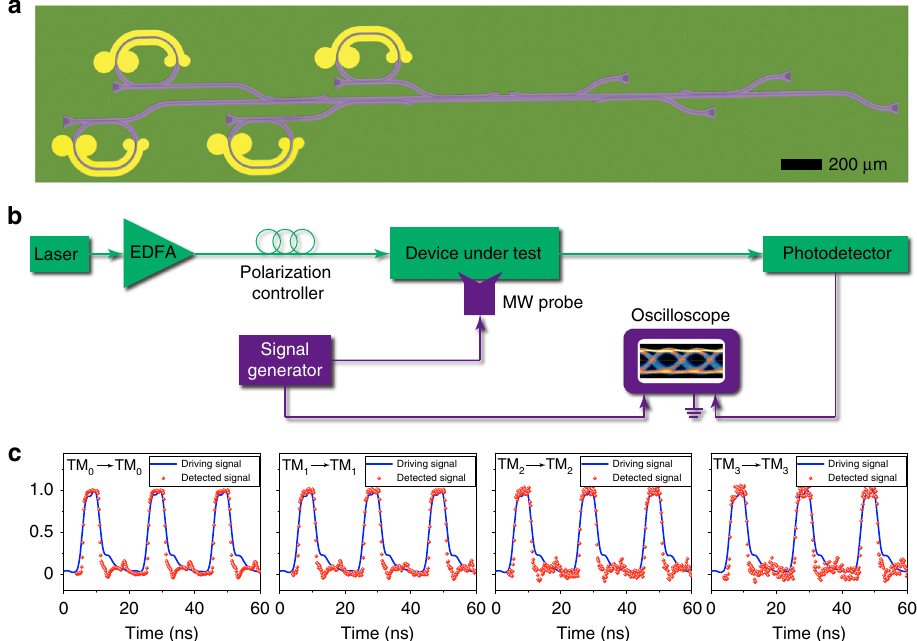
Fig. 6 Experimental demonstration of on-chip electro-optic modulation and mode (de)multiplexing. a Optical microscope image of the fabricated mode (de)multiplexer integrated with electro-optic modulators. b Experimental setup for measuring electro-optic modulation and mode (de)multiplexing on a single chip. EDFA: erbium-doped fi ber ampli fi er; MW probe: microwave probe. c Measured modulated signals in the TM 0 ‒ TM 0 , TM 1 ‒ TM 1 , TM 2 ‒ TM 2 , and TM 3 ‒ TM 3